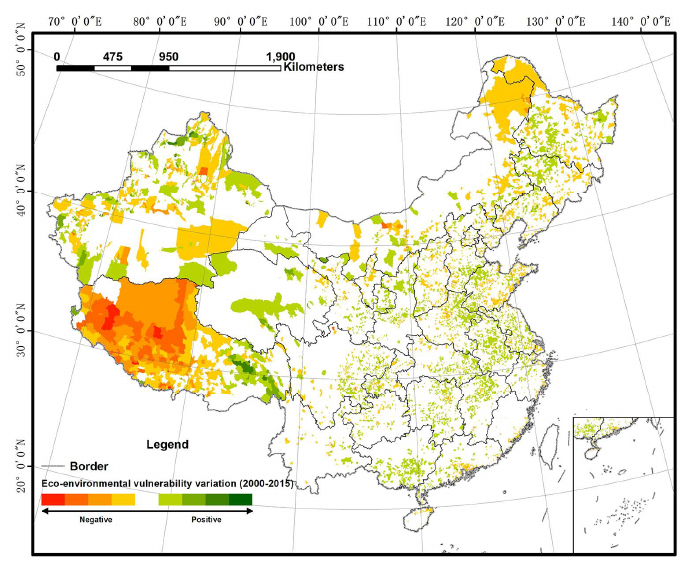
Figure 6. Variation in eco–environmental vulnerability from 2000 to 2015 at the rural–area scale.